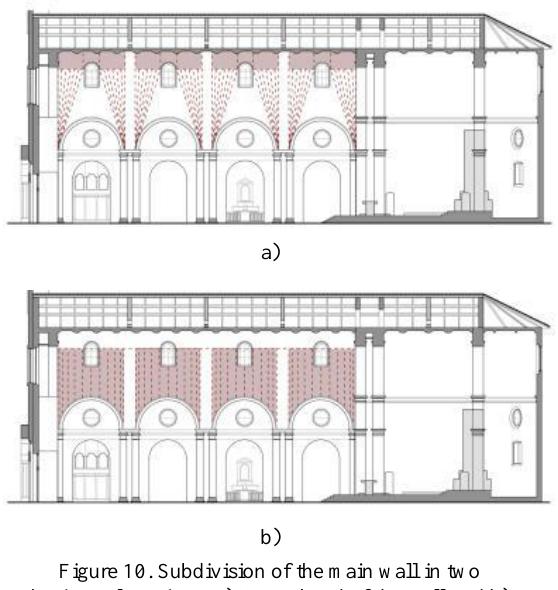
Figure 10. Subdivision of the main wall in two horizontal portions: a) Upper band of the wall and b) Lower part of the wall 5.1.1 Top band of the wall : Primarily the top part corresponds to the portion of wall included between the central covering skewback and the arches skewbacks of the single-windows (Figure 10a). This part was considered as a free body, which in addition to its own weight, supports the load of the central roof. The total load is transferred through the “centered fans” up to the top of the columns (Figure 5). The load transfer scheme is based on the cracks arranged like a centered fan above the columns. The cracks observed, corresponding to the transferring of the weight of the upper band wall to the columns, are pronounced, due to the soil settlements.